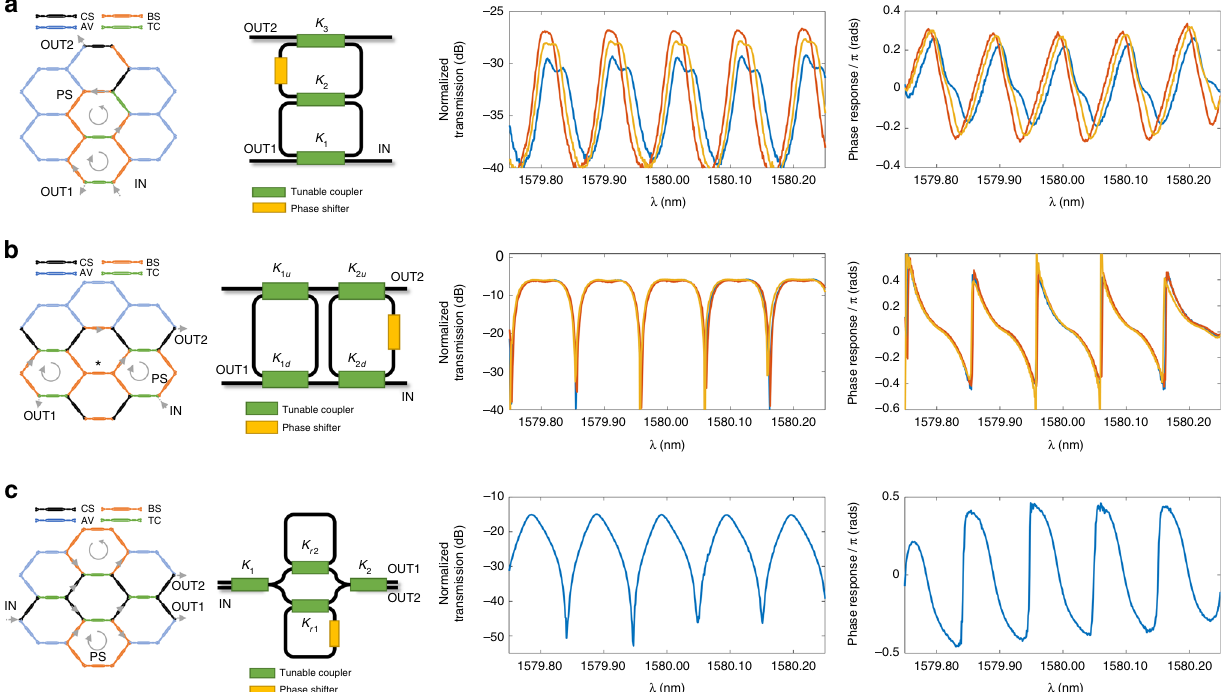
Fig. 5 Experimental results for complex double ring-loaded 6-BUL optical ring resonator fi lters. Waveguide mesh connection diagram, circuit layout and measured modulus, and phase transfer function for a a 6-BUL double optical ring resonator (ORR) coupled resonator waveguide (CROW) fi lter and different values of the coupling constants K 1 and K 2 ; b a 6-BUL double ORR side-coupled integrated spaced sequences of optical resonators (SCISSOR) fi lter and different values of the coupling constants K 1 and K 2 ; c a 6-BUL double ORR ring-loaded Mach Zehnder Interferometer (MZI). BUL, basic unit length; CS, cross state; BS, bar state; AV, available; TC, tuneable